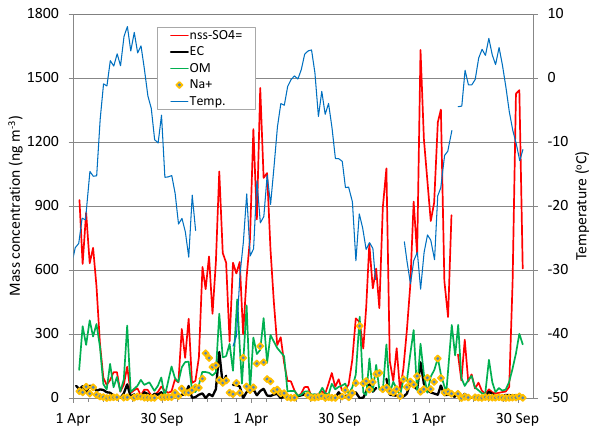
Figure 2. Time series of temperature and weekly-integrated mass concentrations of OM, EC, nss-SO = 10 April 2012 to 14 October 2014.